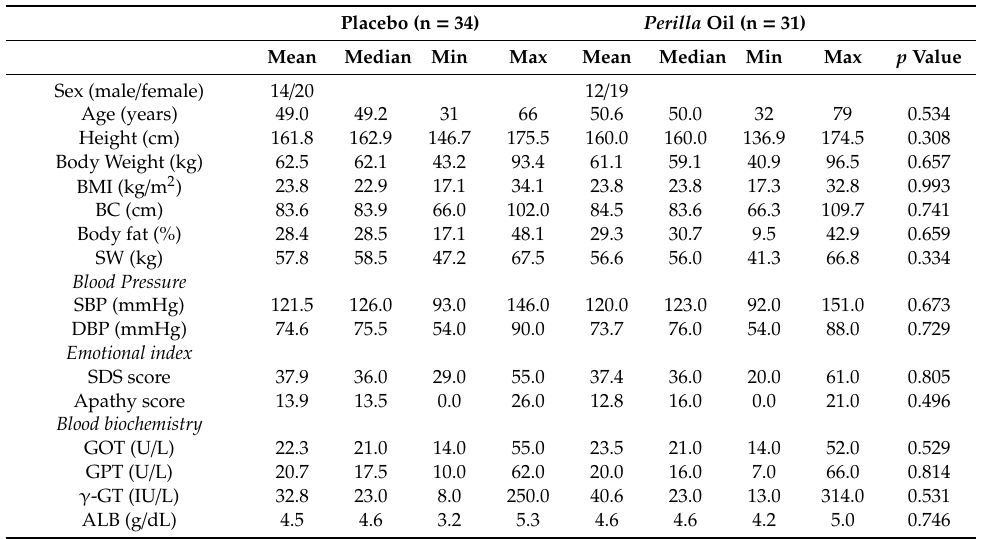
Table 3. Participant’s parameters after 12 months